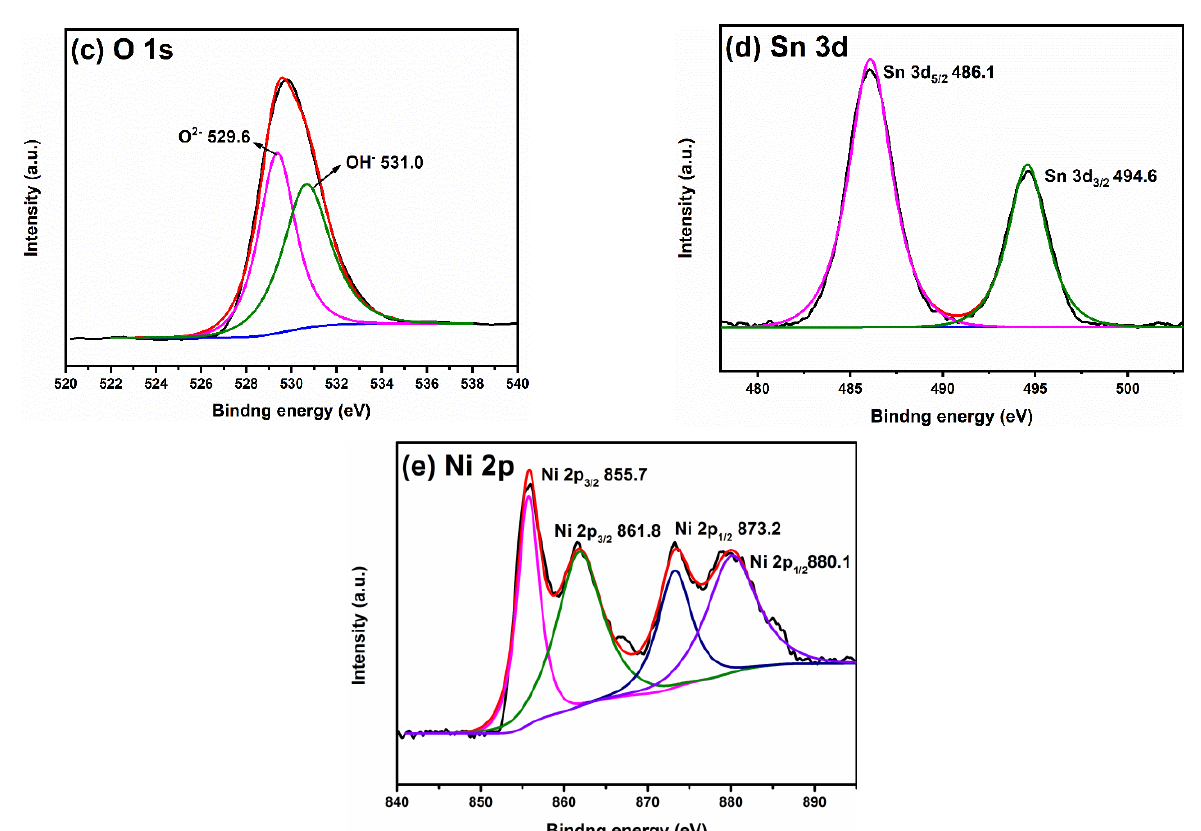
Figure 4. XPS spectra of Sn/Ni–TiO 2 : ( a ) full spectrum, ( b ) Ti 2p, ( c ) O 1s, ( d ) Sn 3d, and ( e ) Ni 2p.